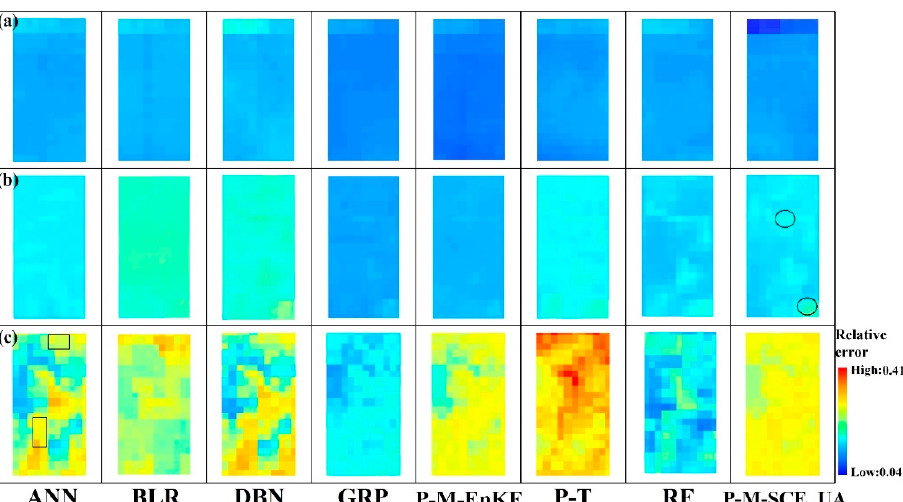
Figure 10. Distribution of relative errors derived from the TCH method with a 30 m resolution at three superstations. ( a – c ) represent homogeneous underlying surfaces in the upstream region (Arou), moderately heterogeneous underlying surfaces in the midstream region (Daman), and highly heterogeneous underlying surfaces in the downstream region (Sidaoqiao), respectively. The ellipse areas in Figure 10b represent village areas, and the rectangular regions in Figure 10c represent bare land areas.